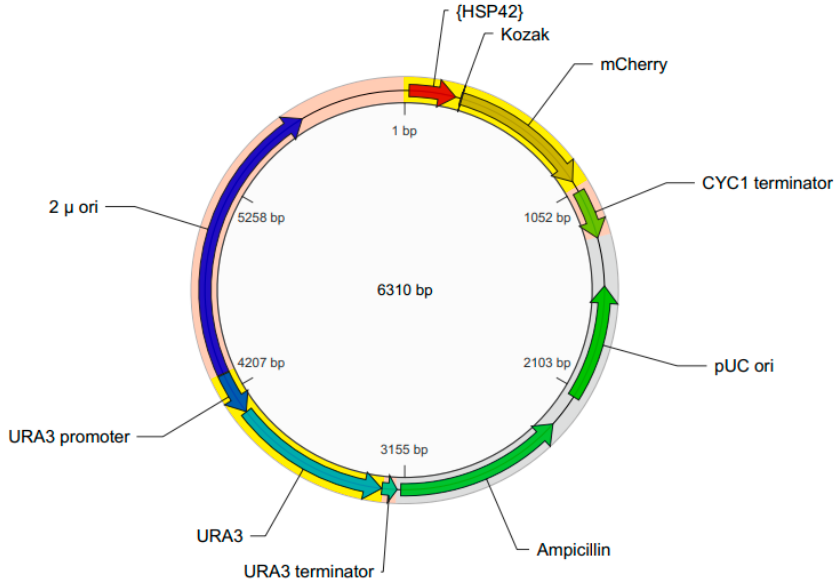
Figure 1. Schematic map of the pYHSRed1 plasmid.